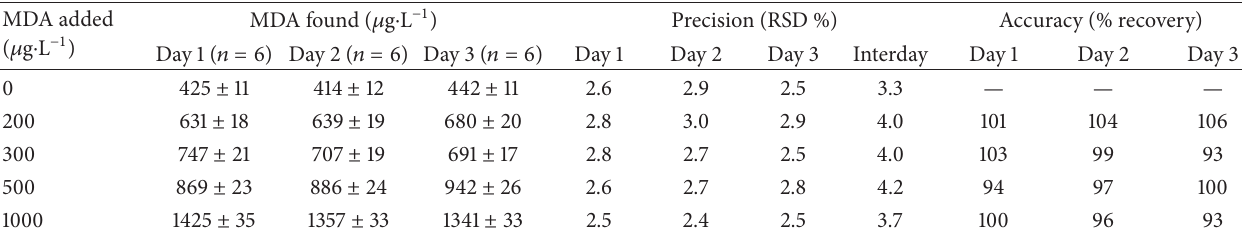
Table 2: Recovery study and analytical performance of the proposed SPE-UPLC-(+)ESI-MS/MS methodology for the MDA determination in melon leaves.